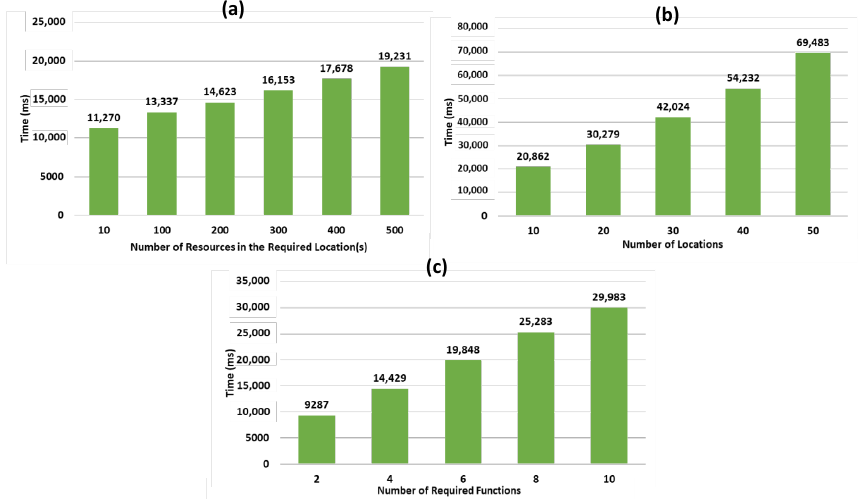
Figure 9. Response time of the resource